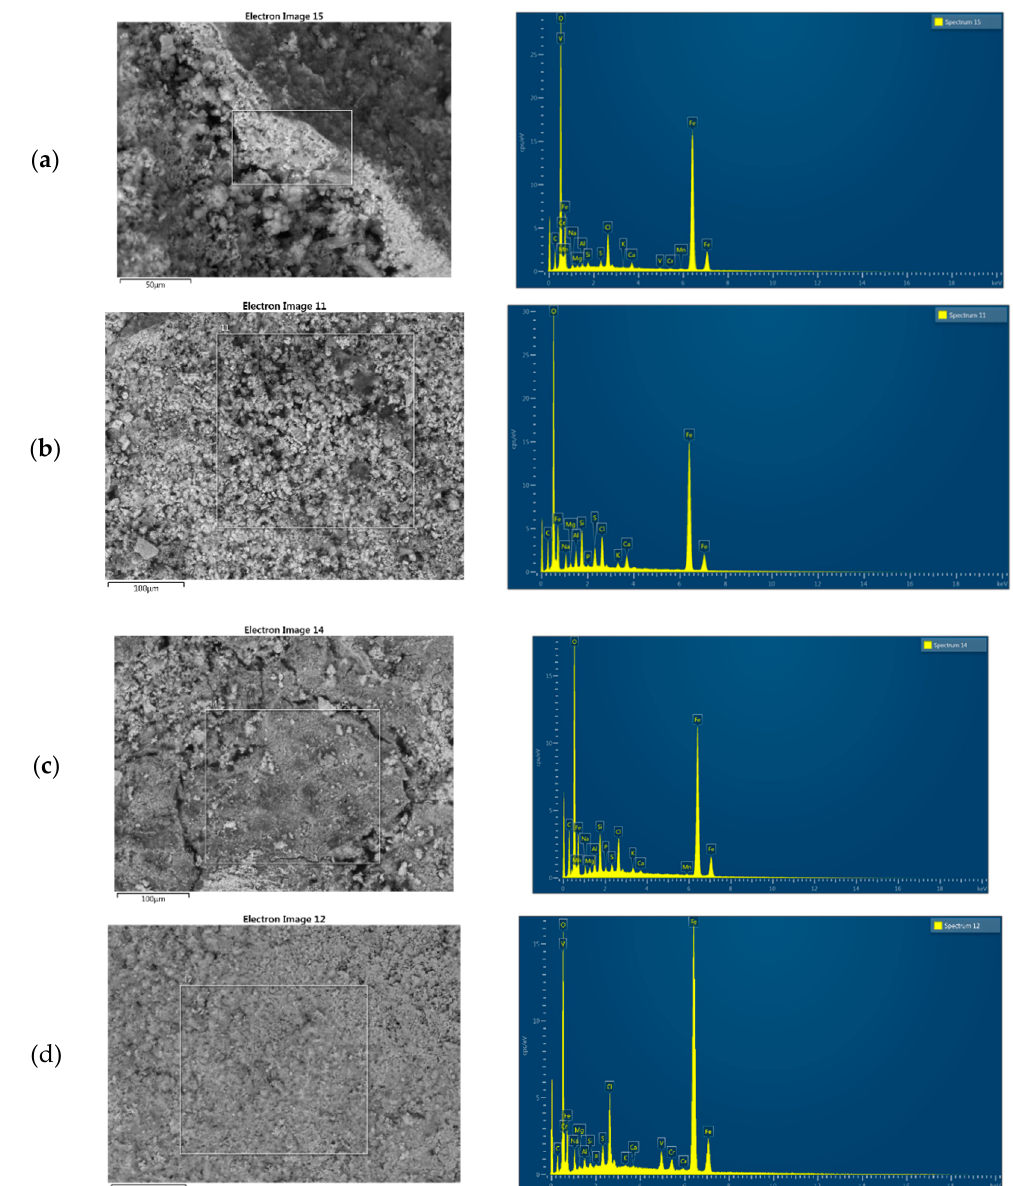
Figure 12. ( a ) Rust sample on sample holders, ( b ) Sample in vacuum chamber for SEM analysis.